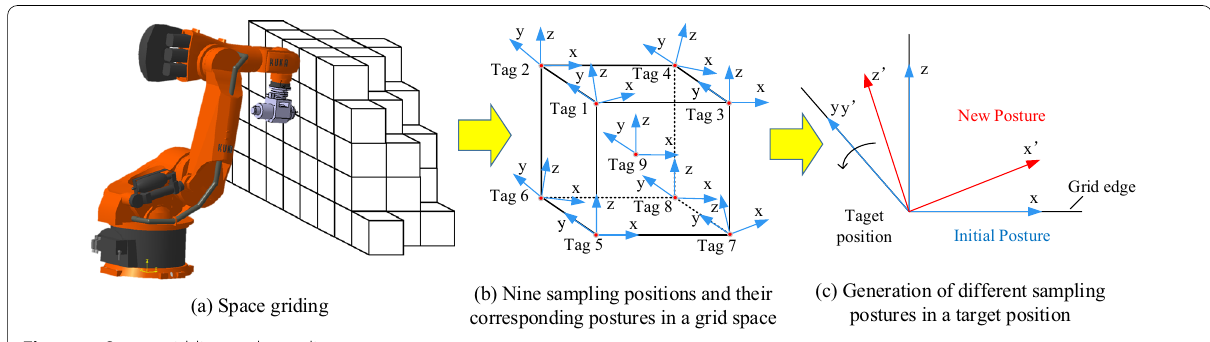
Figure 1 Space gridding and sampling